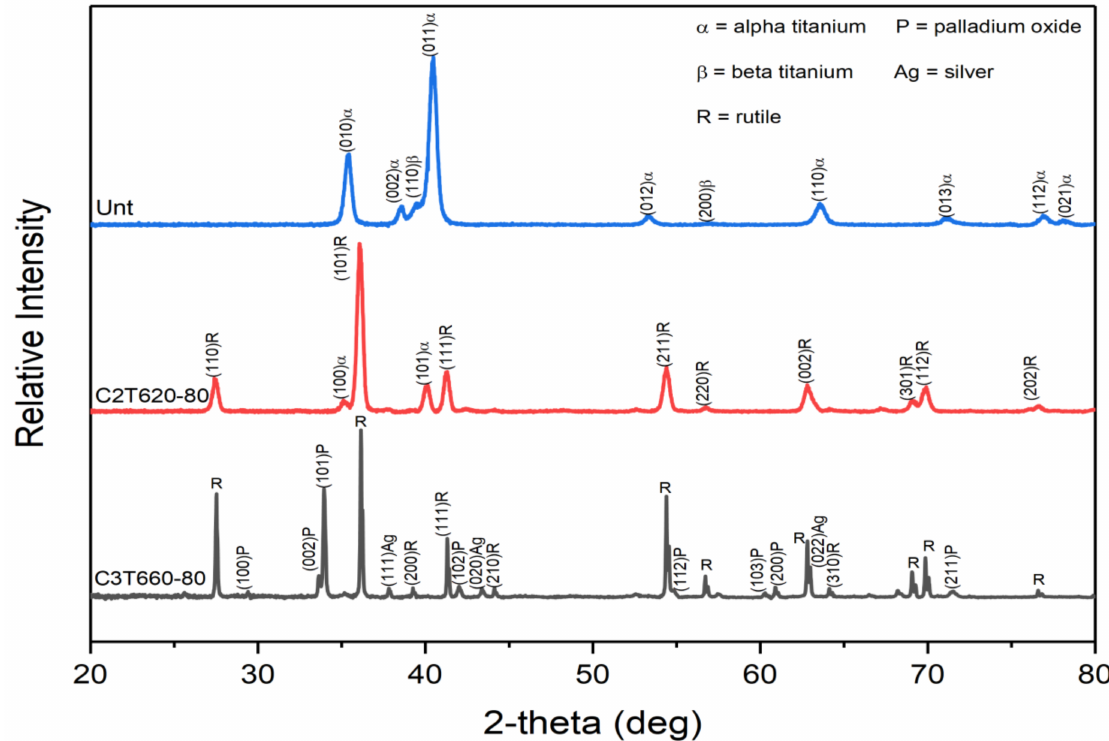
Figure 5. XRD patterns of as-received (Unt), C2T620-80 and C3T660-80PdAg